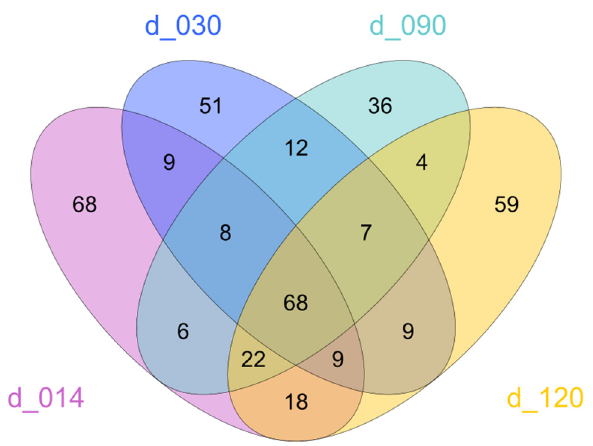
Figure 4. Venn diagrams displaying Amplicon Sequence Variants (ASVs) obtained from fish samples at d14, d30, d90, and d120, including only abundant ASVs, i.e., ASVs that represent at least 1% of filtered reads in at least one sample.